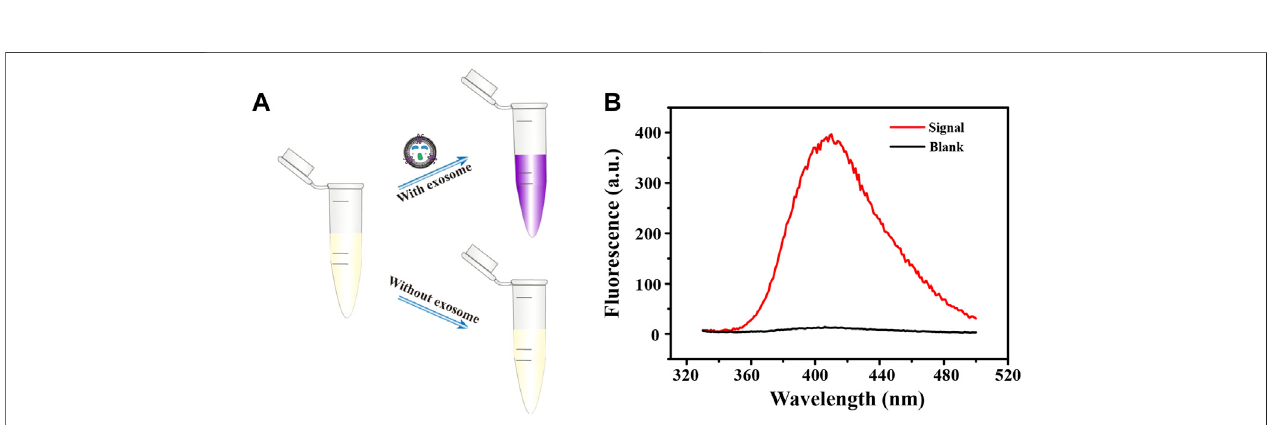
FIGURE 2 | Brief schematic (A) and fl uorescence emission spectra (B) of fl uorescent biosensing protocol in the detection of exosomes.